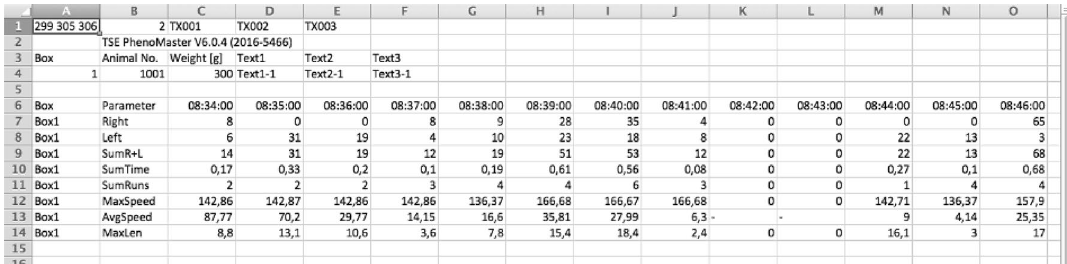
Figure 5. VE data exported to a spreadsheet program. Every minute the wheel rotations are noted (“Right” rotations to the right; “Left” rotations to the left; “Sum R + L” the sum of rotations to the right and to the left) as well as the duration of the activity (“Sum Time”) and the number of runs (“Sum Runs”). Additionally, maximum speed, average speed and the length of activity is calculated (“MaxSpeed”; “AvgSpeed”; 3, Animal C on antenna 6 changing to antenna 5. Only animal A fulfills both premises (a) entering one of the antennas the running wheel is placed on (in this case antenna 2) and (b) is not detected by the radiotelemetry system during wheel rotations are counted (which occurs as soon as an animal enters the wheel as described above). According to this the VE is assigned to animal A.